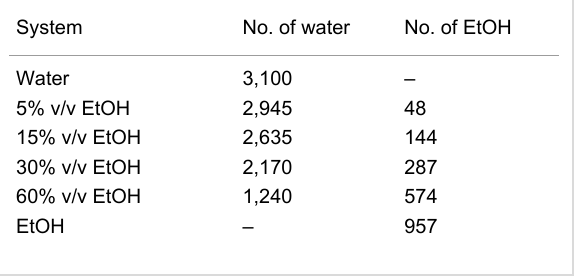
Table 1: Number of co-solvent molecules in the six simulation systems.